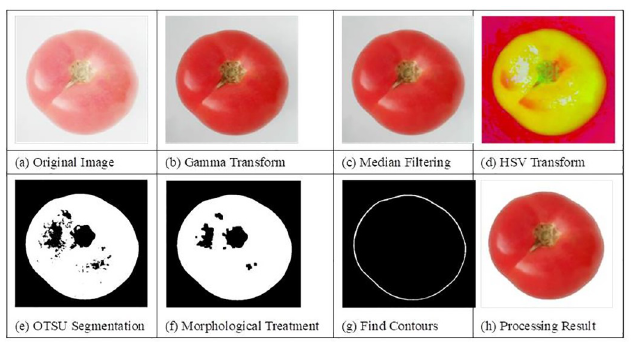
Contours; h) Processing Result).